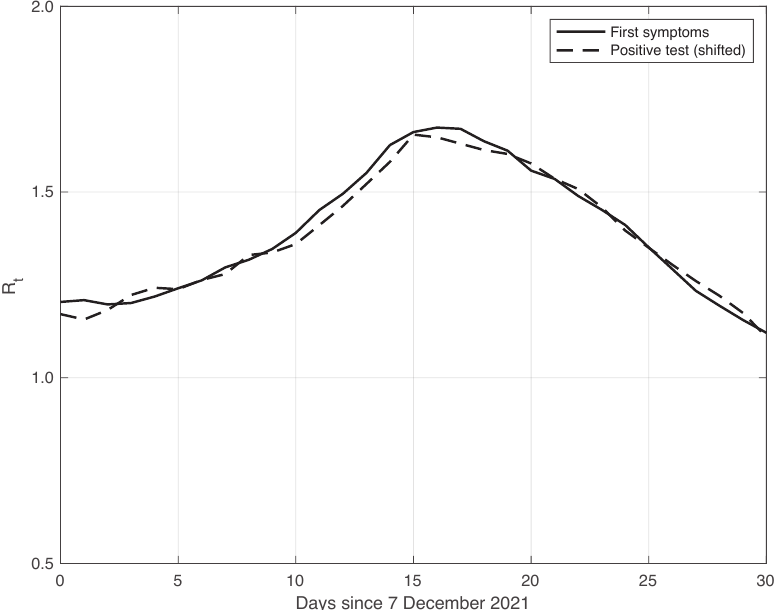
Figure 6. Sequence of the reproduction number R t estimated by the standard method for real SARS- CoV-2 Italian data from 7 December 2021 to 6 January 2022. The continuous and dashed lines refer to the first symptoms and the shifted positive test sequences, respectively. The estimated optimal shift is 4